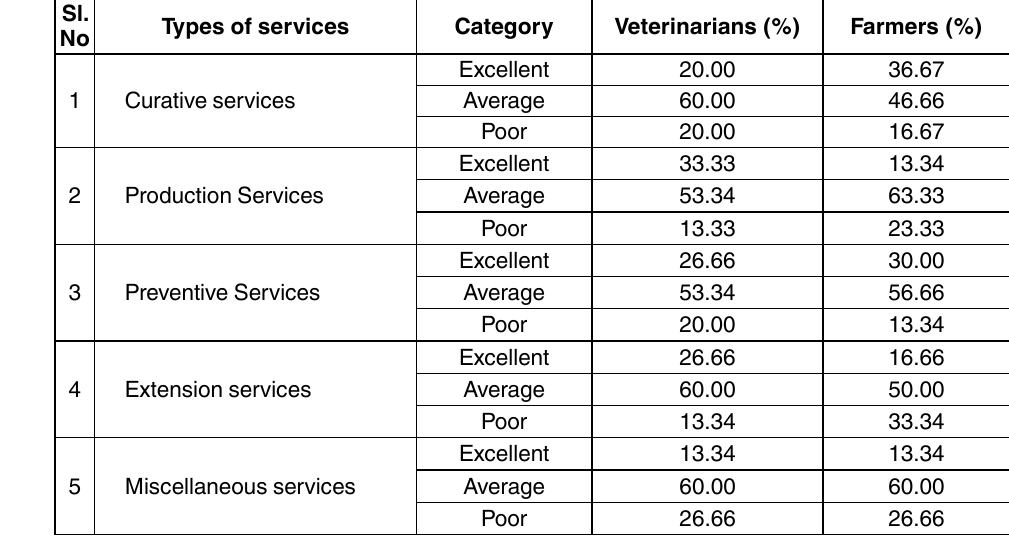
Table 4. Distribution of the veterinarians and livestock farmers according to their perception on livestock service delivery provided by the dairy cooperatives Sl.